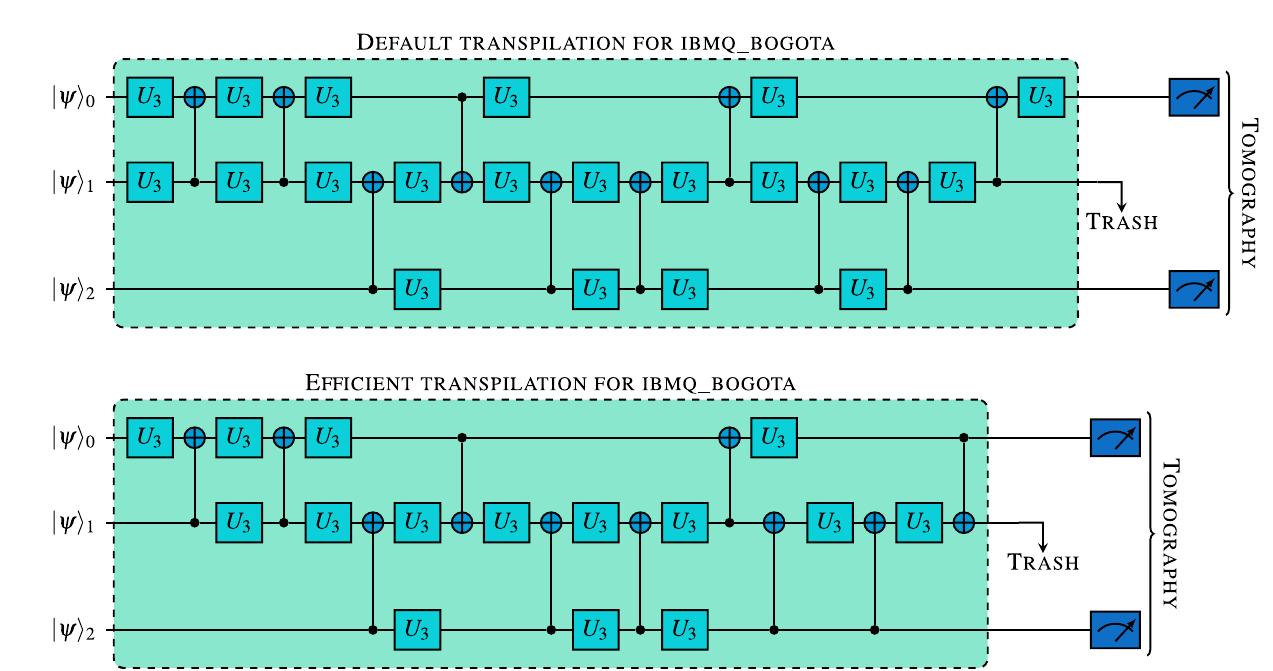
Figure 2. Schematic representation of transpiled compression circuits. Here, single qubit rotations labeled U 3 (see Eq. (1) for definition) are implemented by 1–5 basis gates, i.e. R z rotations and √ X . In total, the default